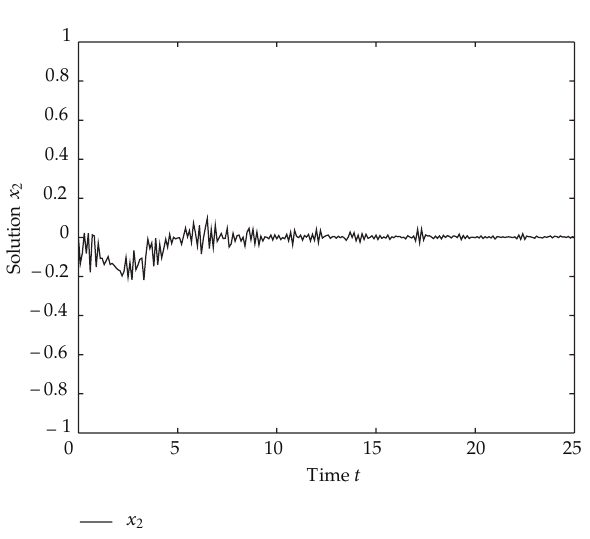
Figure 4: Numerical solution x 2 (cid:6) t (cid:7) of system (cid:6) 4.1 (cid:7)